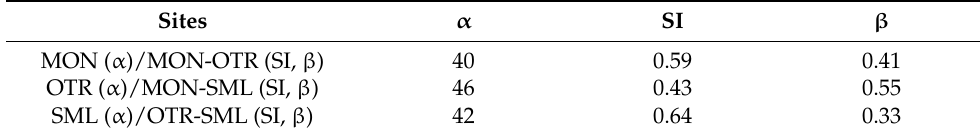
Table 2. Number of species ( α ), Sörensen Index (SI) and Whittaker Index ( β ) for the polychaete assemblages of the mesophotic bioconstructions along the Apulian coast.